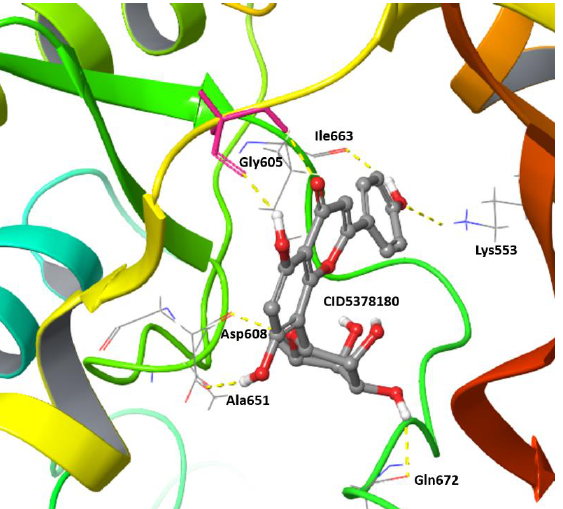
Figure 7. Molecular docking of the top selected isoflavonid, the compound 5378180, to human Mps1 kinase domain (PDB ID 5ljj). The protein is shown in cartoon representation and the compound 5378180 in stick-ball representation. H-bond interactions are shown in yellow dashed lines (Gly605, Asp608, Ala651, Gln672, Ileu663 and Lys553). The Glide score of this interaction was − 14.5